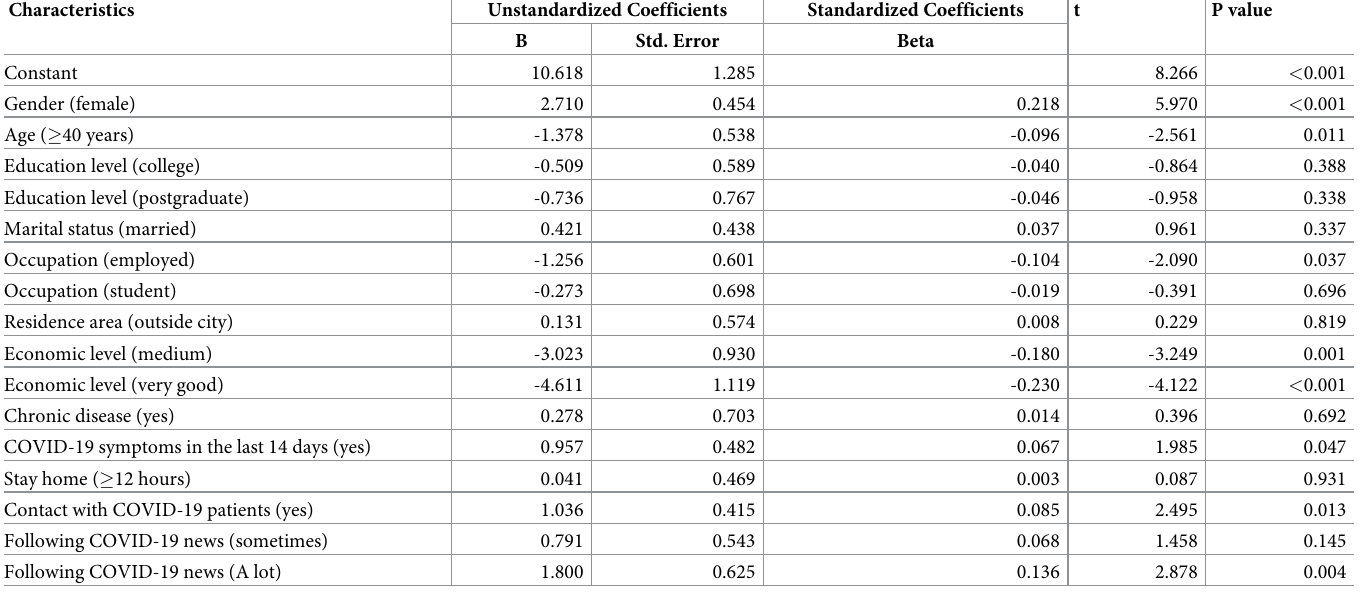
Table 5. Analysis of sociodemographic and clinical characteristics of the respondents on anxiety level by regression